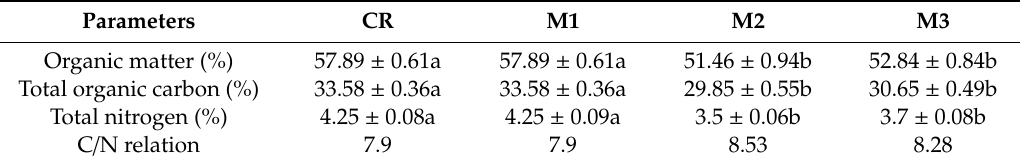
Table 2. Characterization of the four pre-composted mixtures of pineapple waste and load material before vermicomposting. Parameters